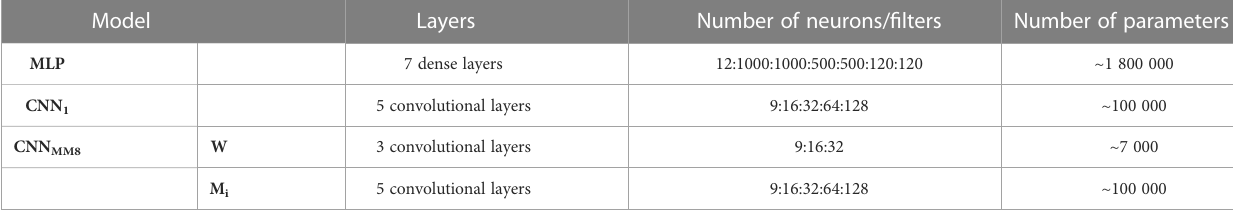
TABLE 1 Summary of the models ’ architectures. CNN MM8 corresponds to the multi-mode CNN composed of an attention-based module W and 8 CNNs submodels M i trained in parallel. Model